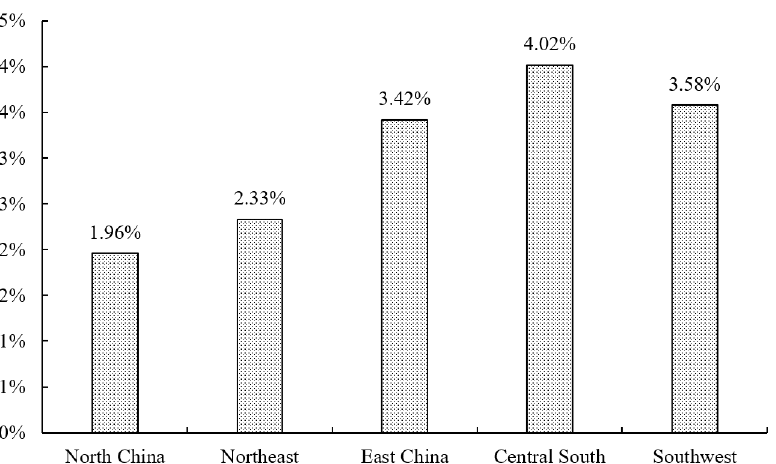
Figure 1. Rice harvest losses in different regions of China. Note: The loss rate of each region is the arithmetic average of the harvest loss rate of all farmers in this region.